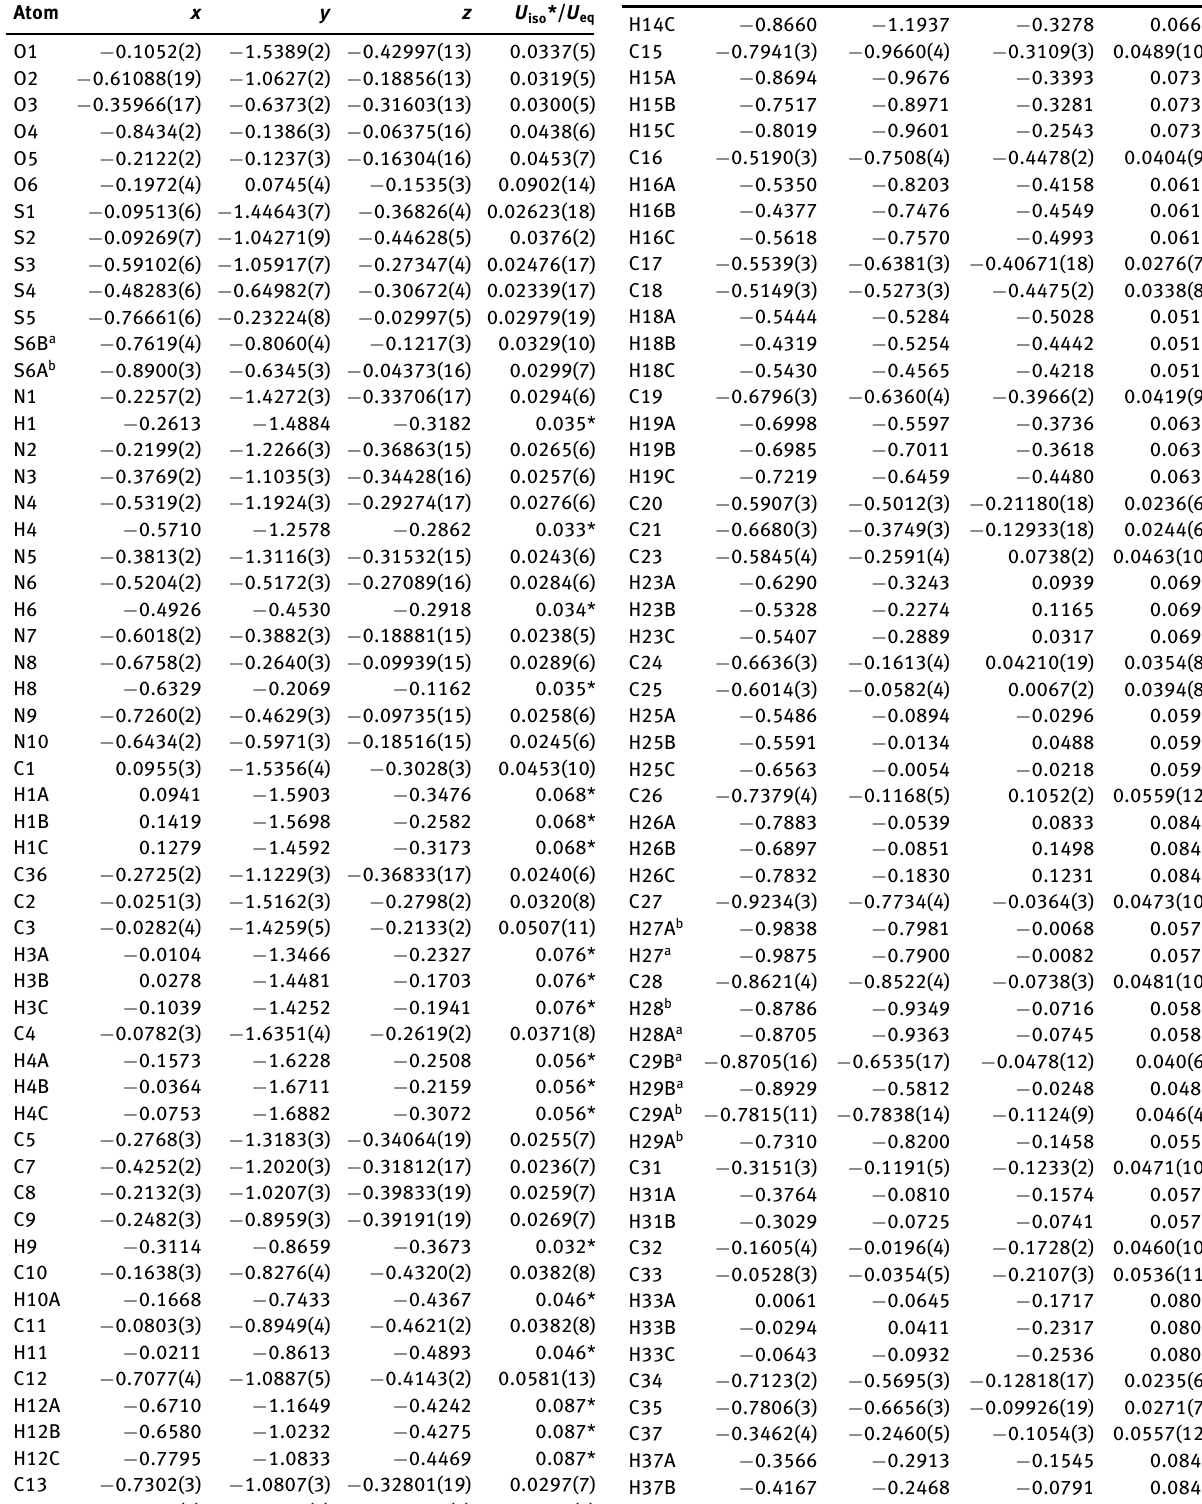
Table 2: Fractional atomic coordinates and isotropic or equivalent isotropic displacement parameters (Å 2